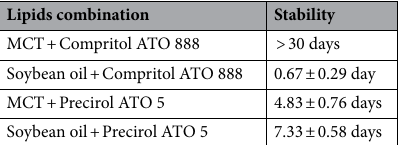
Table 1. Stability properties of the GenNLCs formulated with different combinations of liquid lipids and solid lipids (mean ± SD) (n =